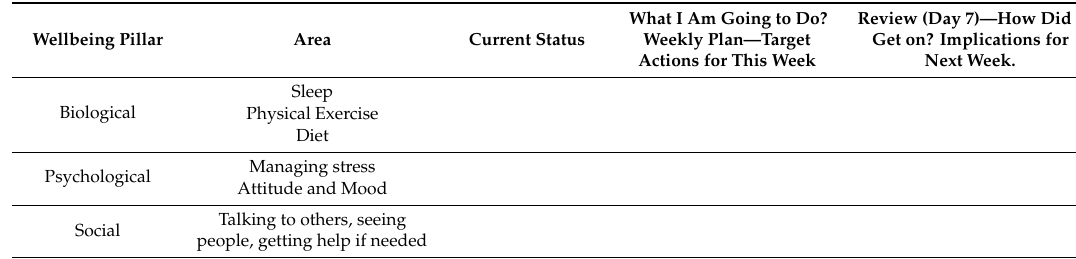
Table 10. Example wellness weekly plan and Table 10 . Example wellness weekly plan and review .